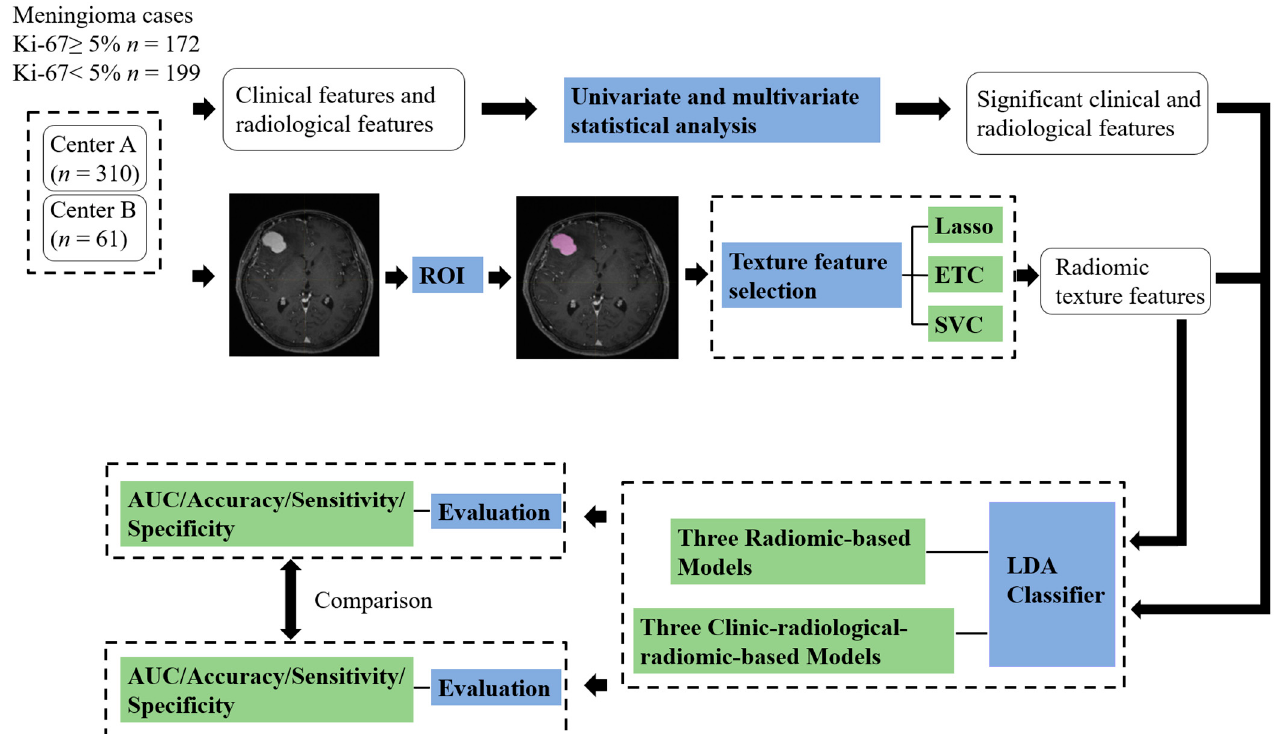
Figure 3. The workflow for the development of machine learning models to predict the Ki-67 index in meningioma patients. ETC: Extra tree classifier; Lasso: Least absolute shrinkage and selection operator; LDA: Linear discriminant analysis; SVC: Support vector machine; ROIs: Region of interests; AUC: Area under curve.